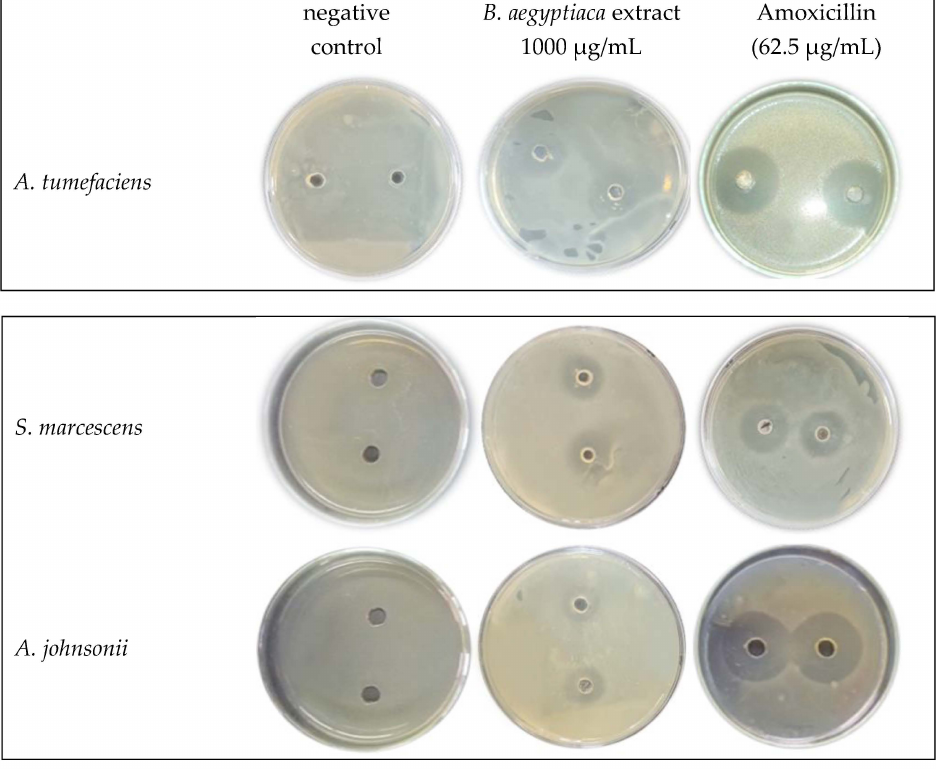
Figure 3. Growth inhibition of three bacterial species: Seratia marcescens , Acinetobacter johnsonii , and Agrobacterium tumefaciens , on NSA medium in response to the treatment with B. aegyptiaca methanolic fruit extract at the highest concentration (1000 µ g/mL) compared with the negative control and amoxicillin at 62.5 µ